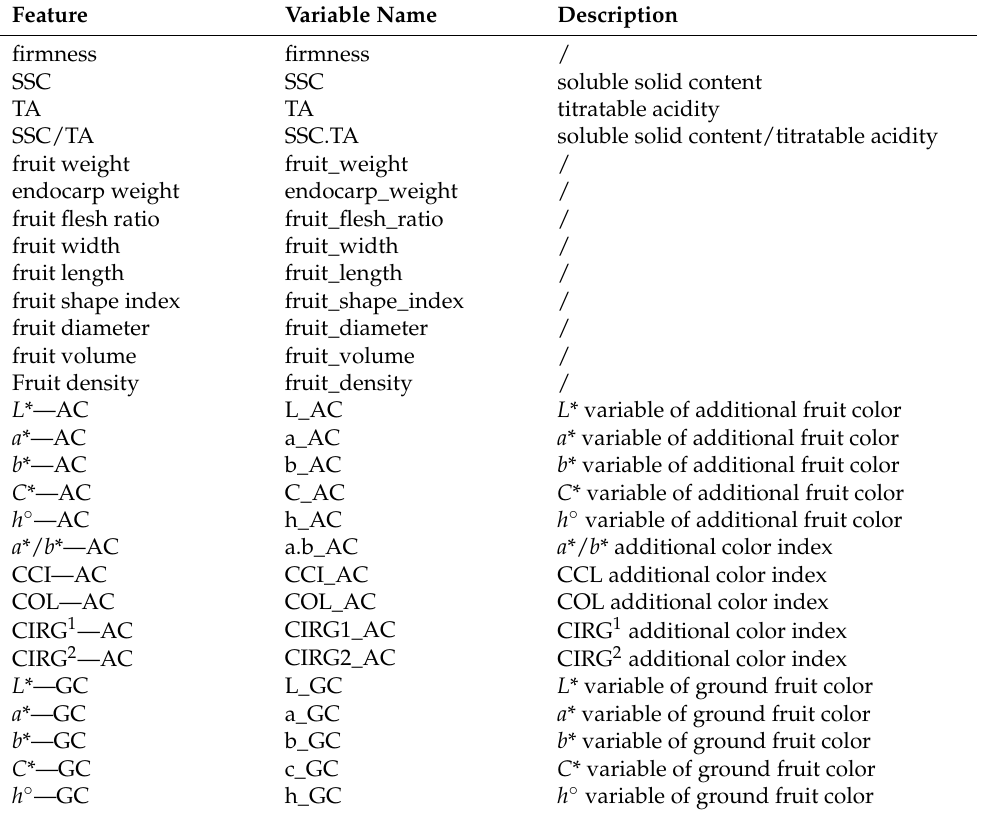
Table A1. Dataset with a list of all the variables used in this